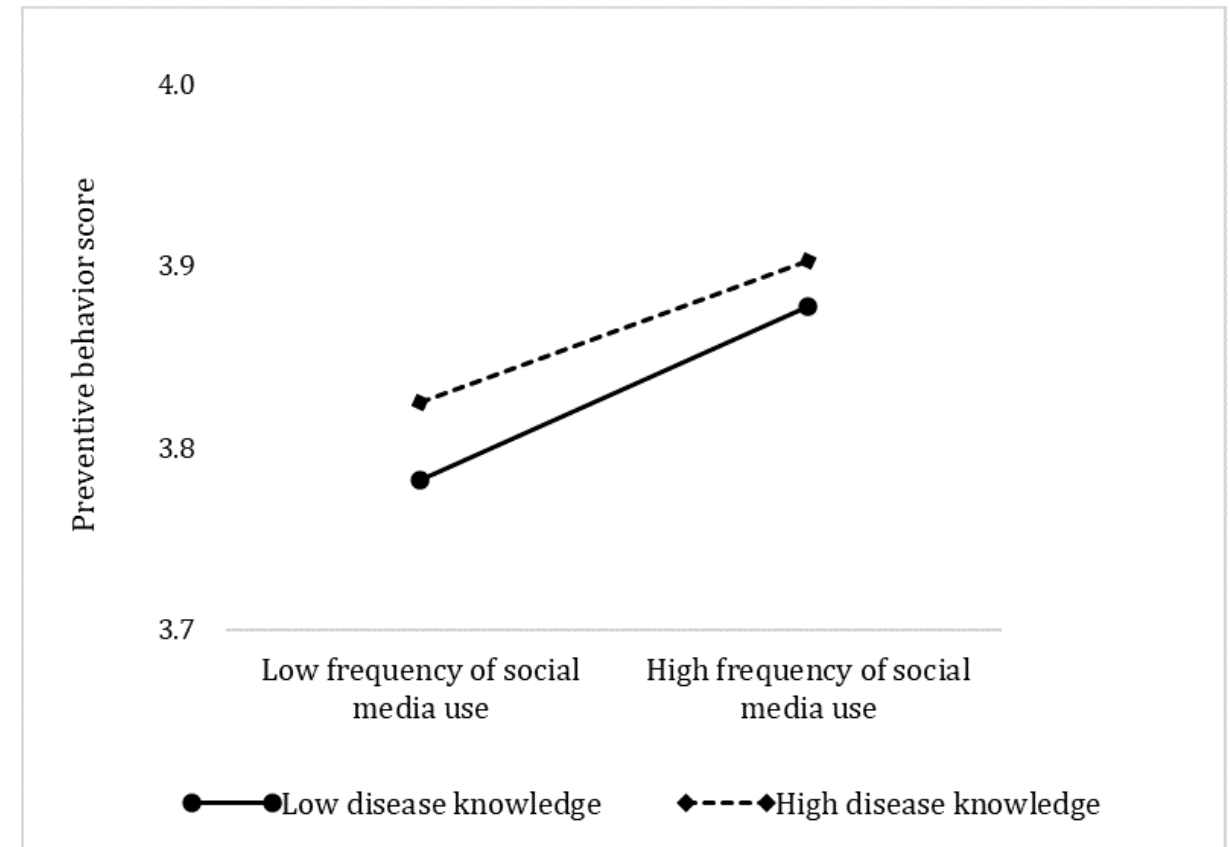
Figure 3. Simple slope test of the moderating effect of disease